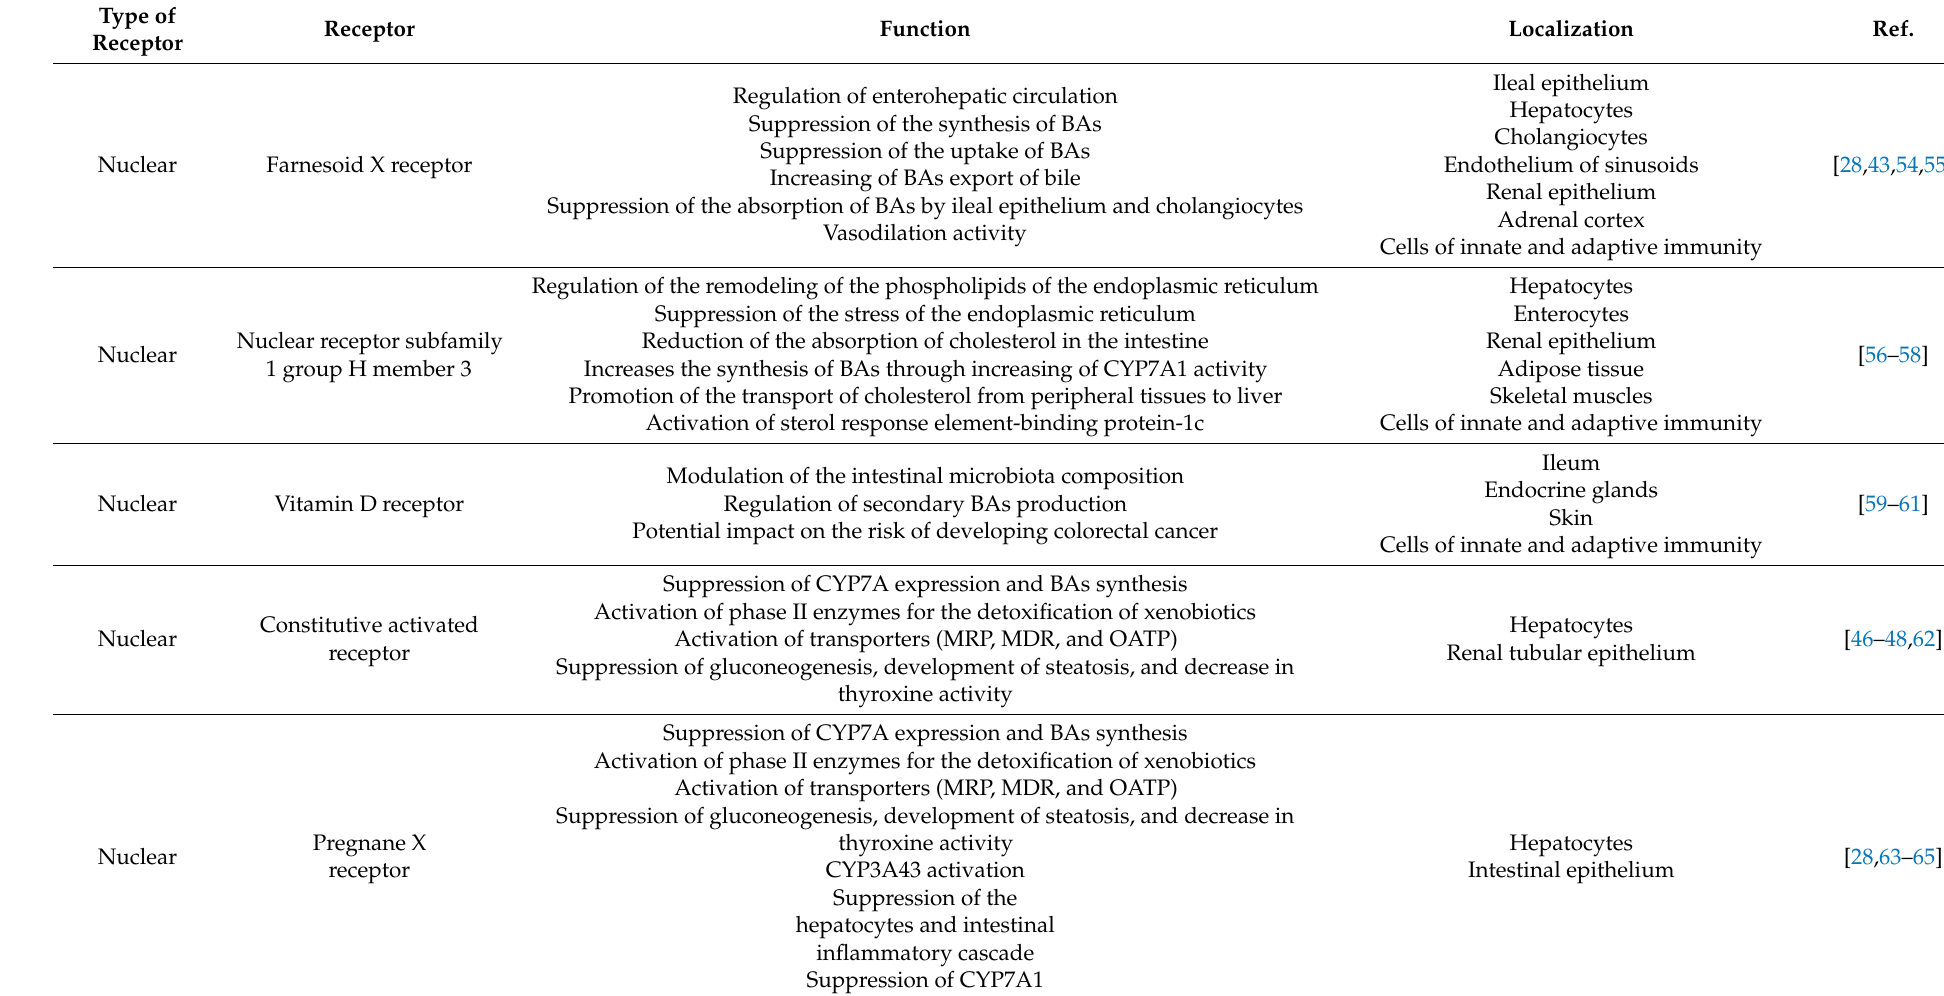
Table 1. Receptors of bile acids and their functions in the human